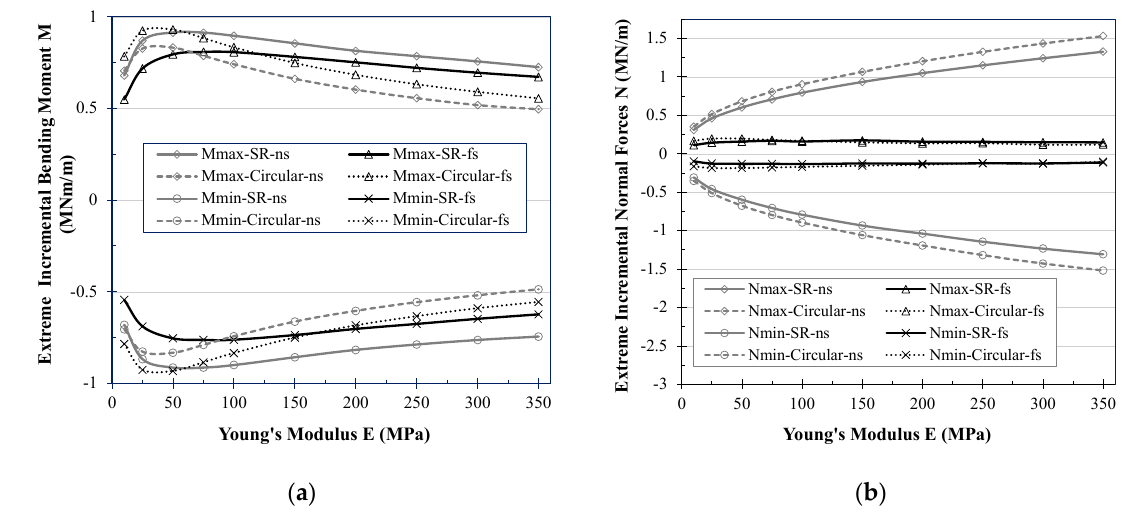
Figure 11. Effect of the E value on the internal forces for the circular and sub-rectangular tunnel linings. ( a ) Incremental bending moments; ( b ) incremental normal forces.